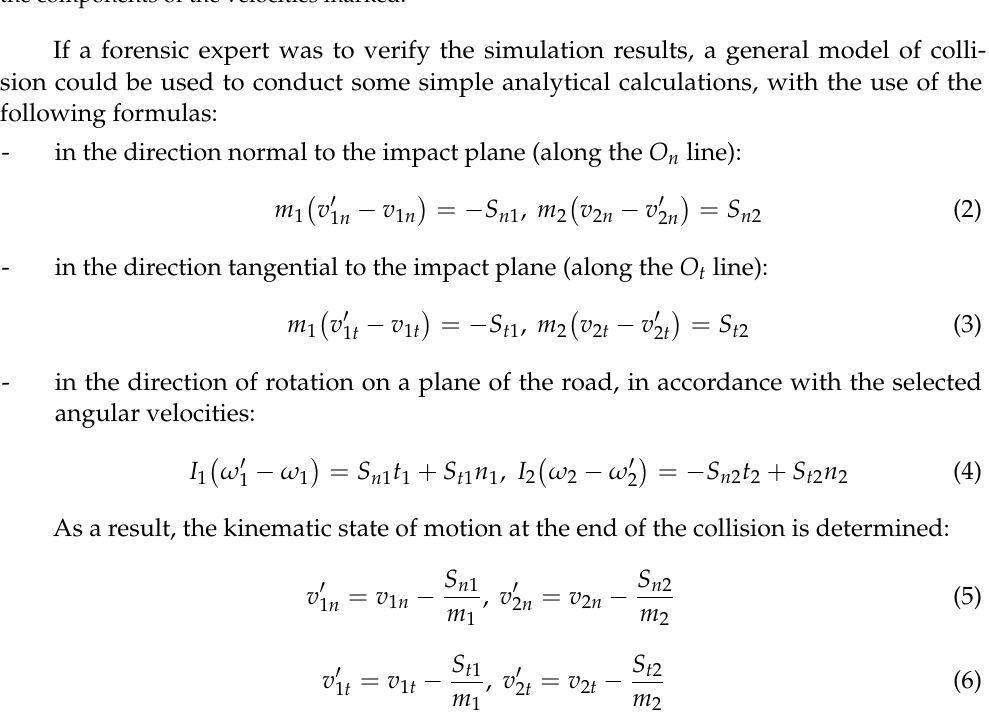
Figure 6. The mutual location of both vehicles at the beginning of the collision with the angles and the components of the velocities marked.